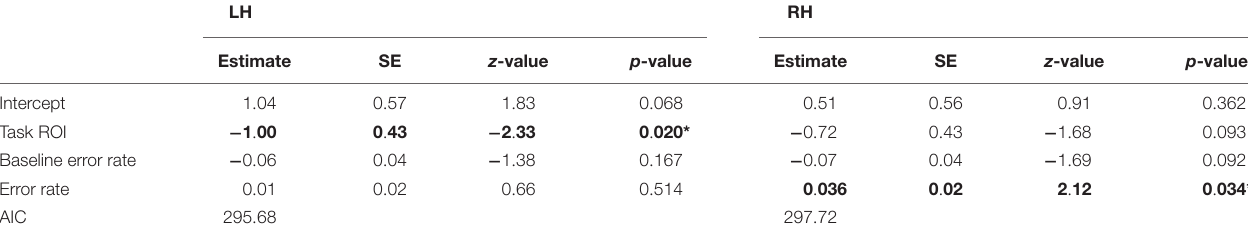
TABLE 4 | Logistic regression model output for the LH and